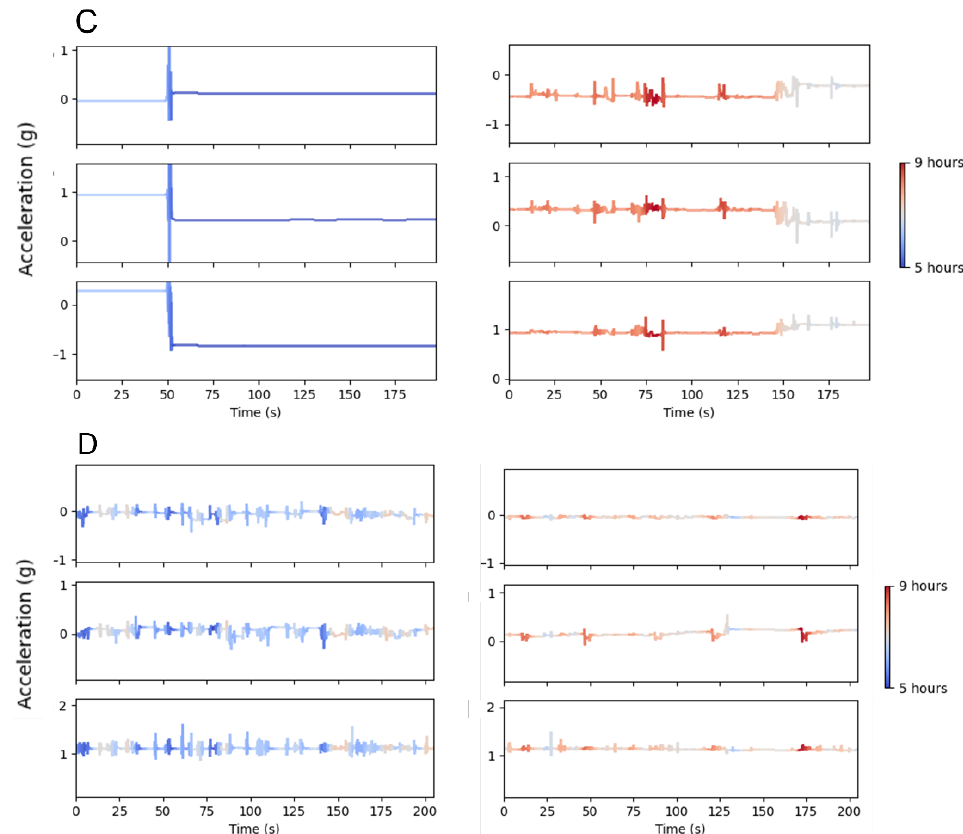
Figure 6. Class activation maps of classified acceleration signals produced from CNN outputs of DixonNet and ResNet-18 for sitting and sleep history. ( A ) DixonNet sitting history; ( B ) ResNet-18 sitting history; ( C ) DixonNet sleep history; ( D ) ResNet-18 sleep history. Each individual plotted signal represents the x, y and z axis of the accelerometer, respectively (from top to bottom). The colour of the line is representative of the strength in confidence of the class prediction (sitting or sleep history). The Y axis is centred on the mean of each signal ± 0.5 g, meaning there is a constant 1-g scale for each plot. The heat map bar represents the strength of prediction of each